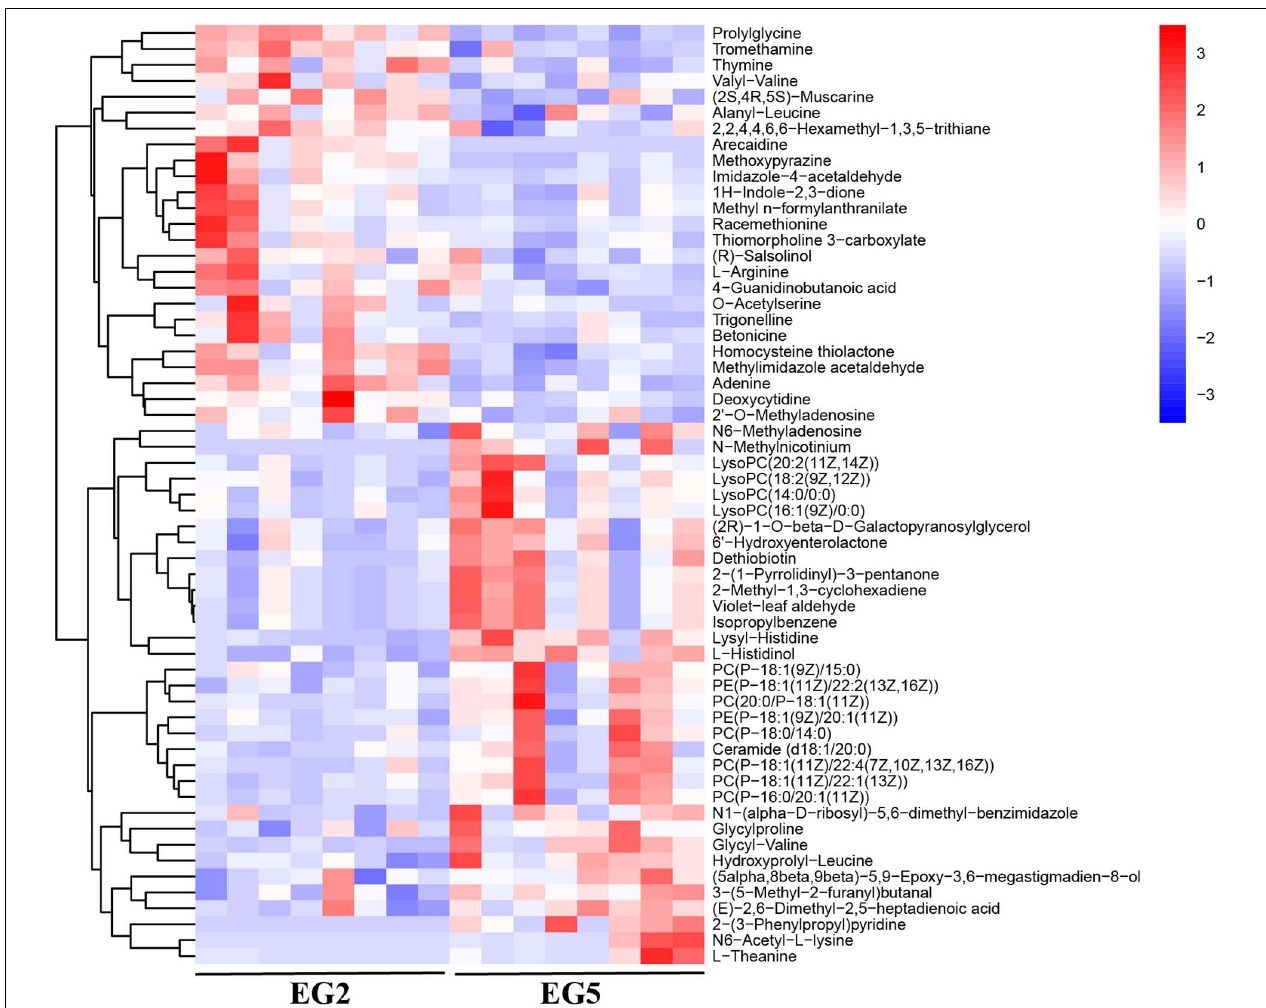
FIGURE 3 | Hierarchical clustering analysis on SDMs from POS. The relative metabolite level is depicted according to the color scale. Red and blue indicate upregulation and downregulation, respectively.